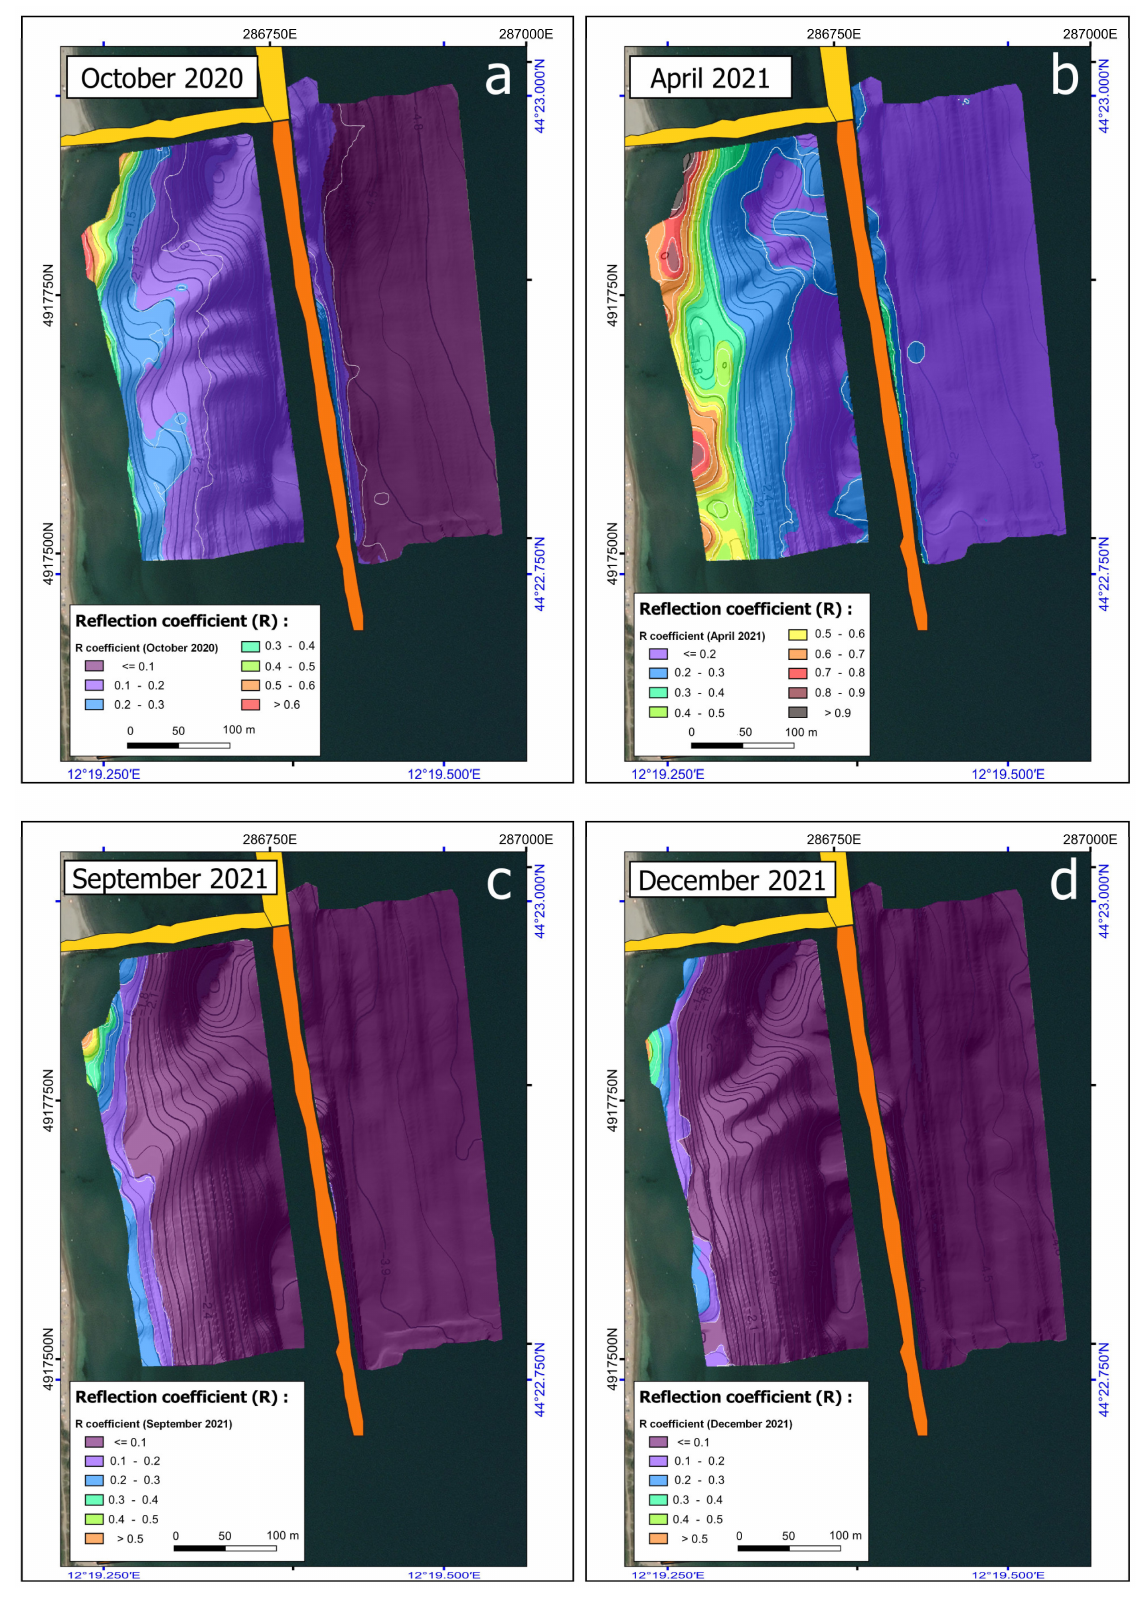
Figure 9. Reflectivity models of the seafloor collected at different time intervals ( a – d ). See also Ref4D.mp4, Figure 3 and Supplementary